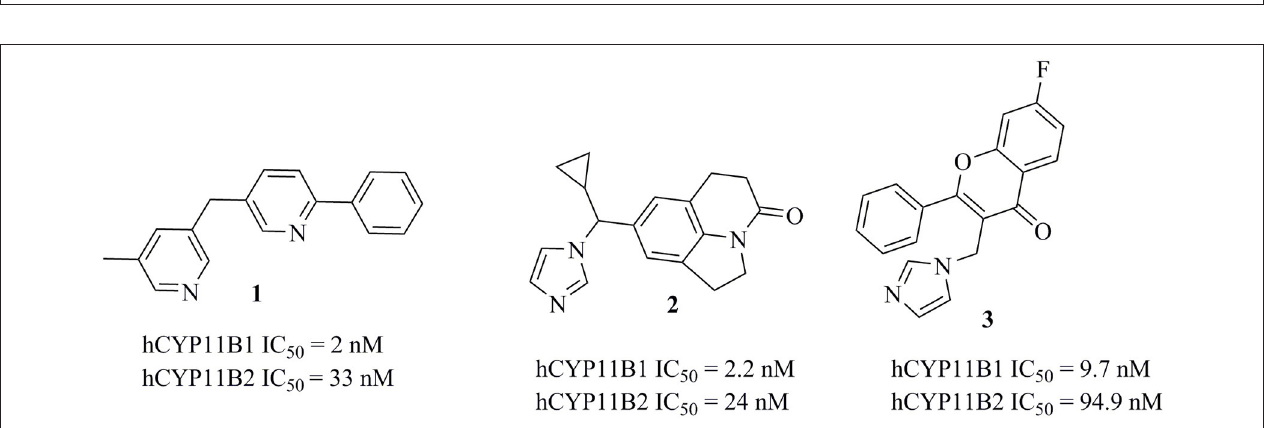
steric exclusion area that was derived from inactive